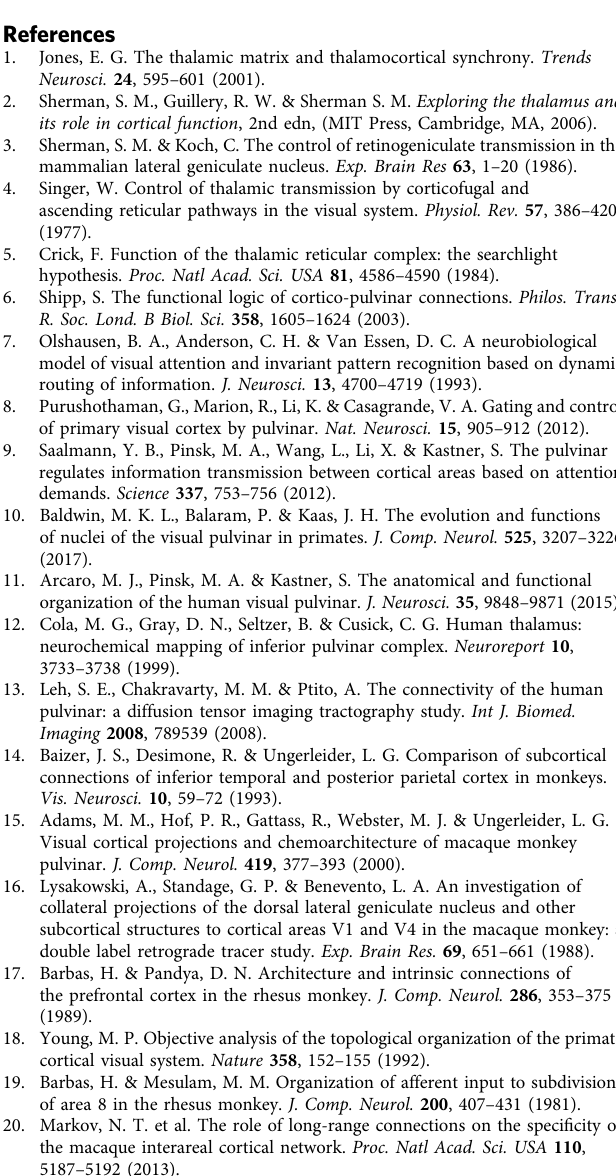
Response magnitudes and signi fi cance were estimated for each subject using a regression analysis. Group-level statistical signi fi cance was assessed across subjects using a one-sample, two-tailed t-tests. The data were corrected for multiple comparisons (FDR) at p <0.05. A d prime index was used to calculate degree of contralateral tuning and attentional modulation across subjects. Statistical signi fi cance was assessed across subjects using a two-sample, two-tailed t tests. Sixteen subjects participated in the object localizer experiment. Voxel-wise response magnitudes and signi fi cance were estimated for each subject using a regression analysis. Voxel-wise group-level statistical signi fi cance was assessed across subjects using a mixed effects meta-analysis that models both within- and across- subject variability. For the ROI analysis, statistical signi fi cance was assessed across subjects using non-parametric testing (Wilcoxon signed rank test) and effect sizes (Cohen ’ s d) were